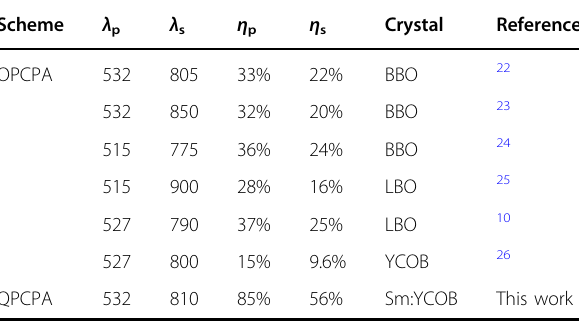
Table 1 Typical pump depletions of reported OPCPA systems